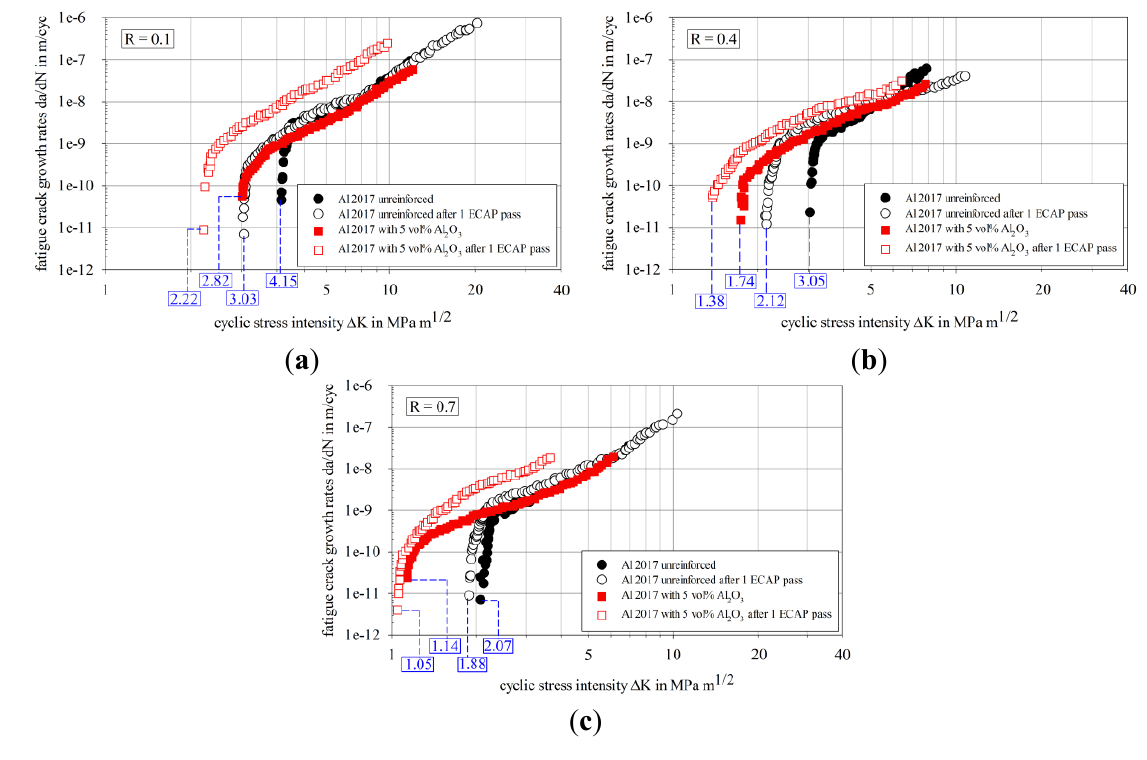
Figure 7. Fatigue crack growth curves of Al 2017 in unreinforced and reinforced conditions with additional ECAP at load ratios of: ( a ) R = 0.1, ( b ) R = 0.4, and ( c ) R = 0.7. The thresholds for the reinforced conditions are lower than for the matrix material conditions. With the increase of the load ratio, this effect becomes more pronounced. The crack growth rates for the reinforced ECAP-processed conditions are generally the